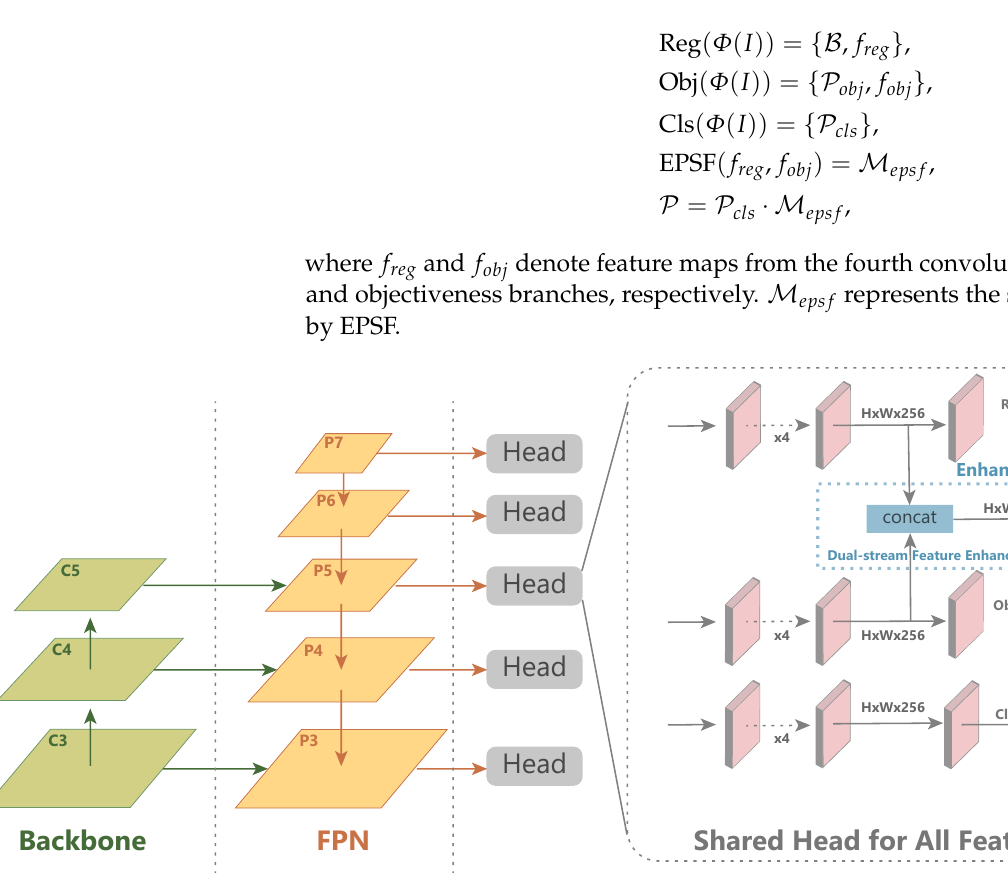
Figure 1. The overall network architecture, where C3 to C5 represent feature maps from the backbone network and P3 to P7 denote feature maps from FPN that will be passed to a shared detection head. The head contains three branches: regression branch, objectiveness branch and classification branch. The proposed Enhanced Positive Sample Filter (EPSF) is applied to the features from the regression branch and objectiveness branch so as to select a single positive sample for each GT instance. EPSF contains two modules, namely Dual-stream Feature Enhancement (DsFE) and Disentangled Mx pooling Filter